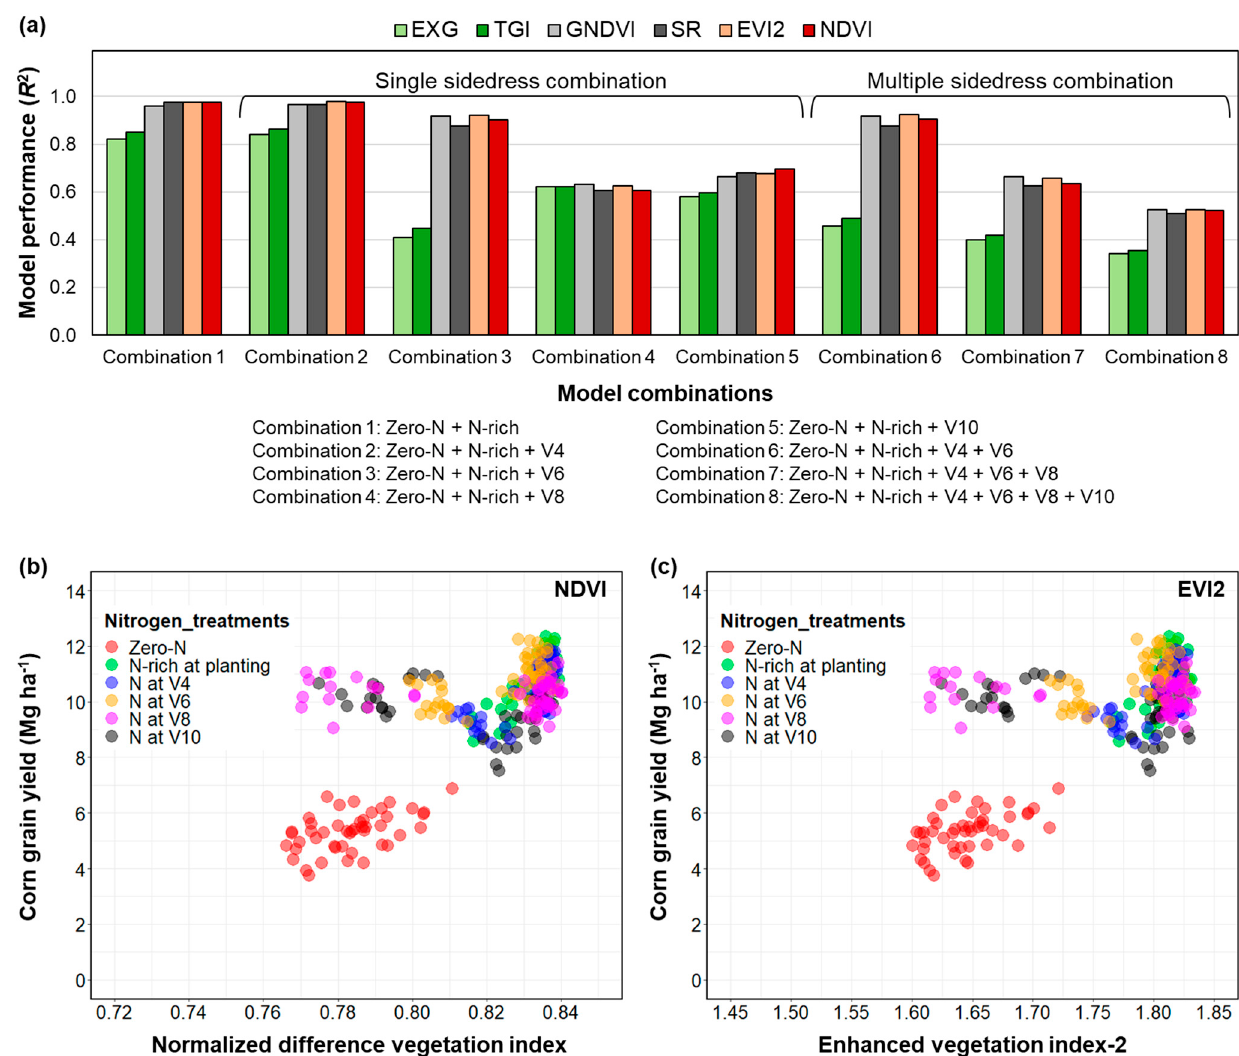
Figure 5. ( a ) Model performances of six different vegetation indices, obtained from imagery captured at R4, for eight different sidedress treatment combinations, ( b ) relationship between the NDVI and yield data for each N treatment, and ( c ) relationship between EVI2 and yield data for each N treatment. Note : Zero-N received starter N (33 kg N ha − 1 ) only, N-rich received 336 kg N ha − 1 prior to emergence, and all other sidedress N treatments received 202 kg N ha − 1 at different growth stages (V4–V10). The scatter plots ( b , c ) were only shown for selected vegetation indices as they were the top two reliable indices for yield